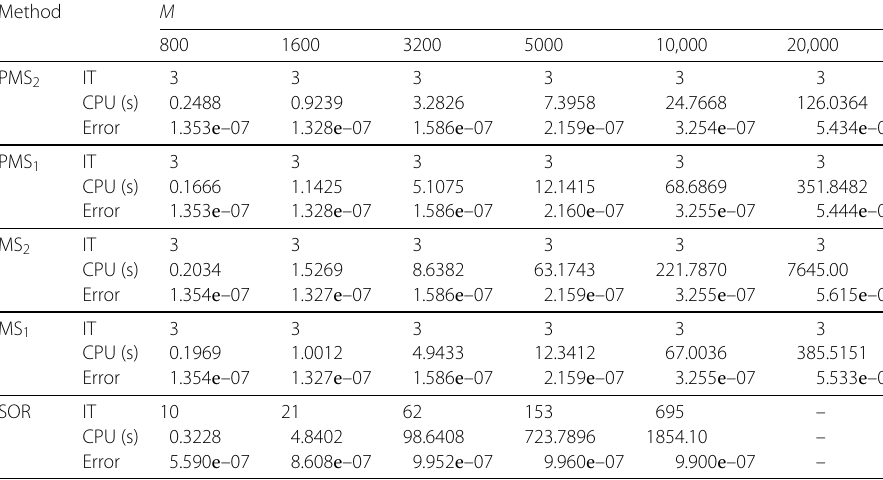
Table 4 Numerical results of the Example 2 for α =